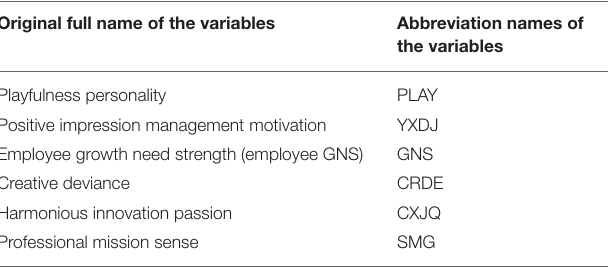
TABLE 2 | Abbreviation names of the variables.